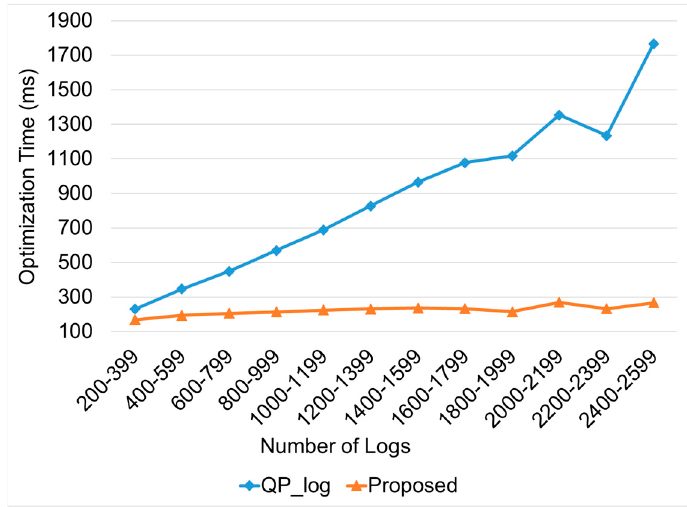
Figure 2. The optimization time as the size of logs increases.